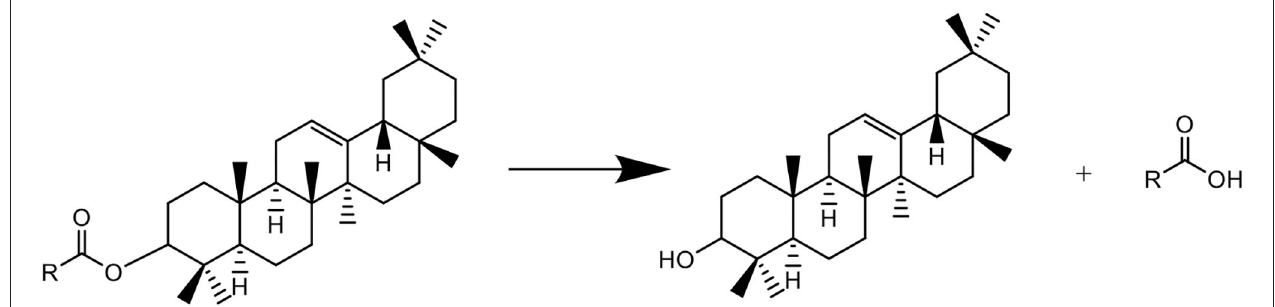
FIGURE 4 | Putative formation of β -amyrin from β -amyrin ester during